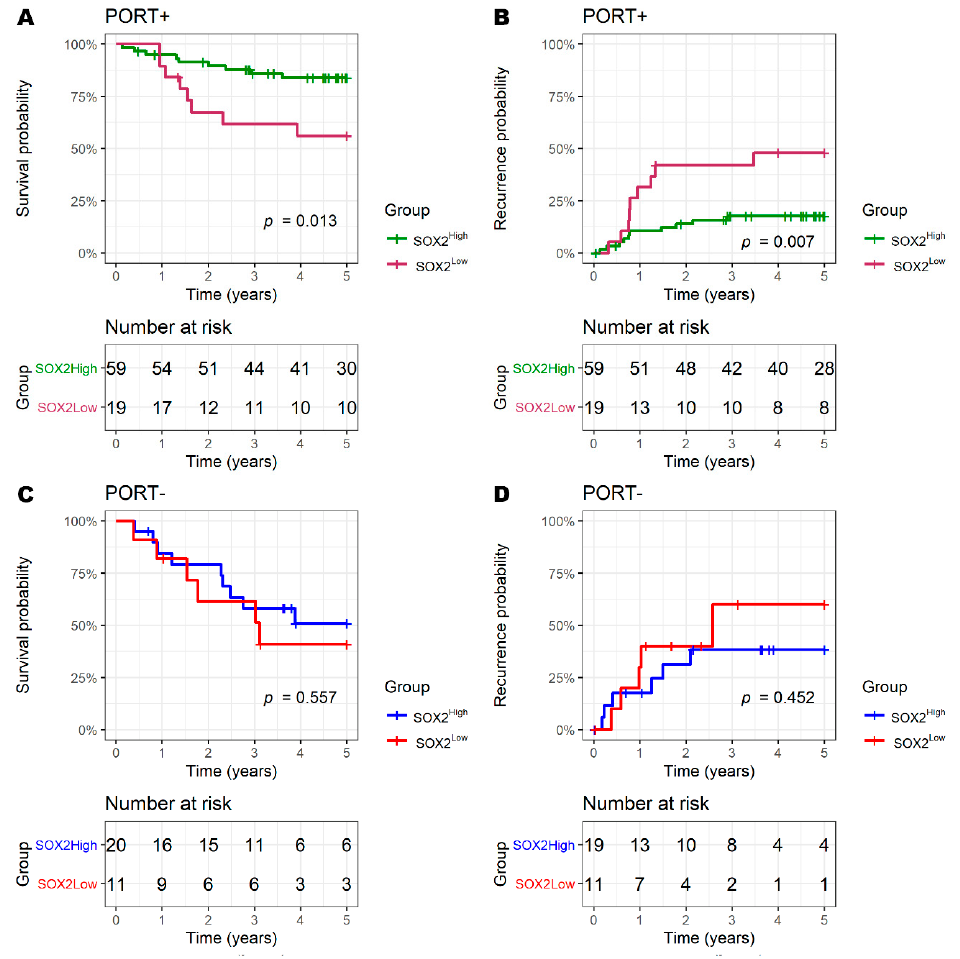
Figure 5. Prognosis according to SOX2 score and postoperative radiotherapy (PORT). In the PORT+ group, the expression level of SOX2 had a significant effect on survival ( A ) and recurrence ( B ). However, in the PORT- group, it did not significantly affect the survival ( C ) and recurrence ( D ).